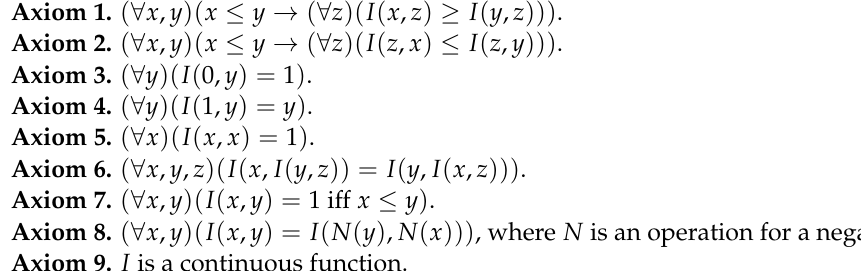
Figure 5. Geometrical interpretations of elements x A , x B and x A → Z ,3 B – the fourth scenario